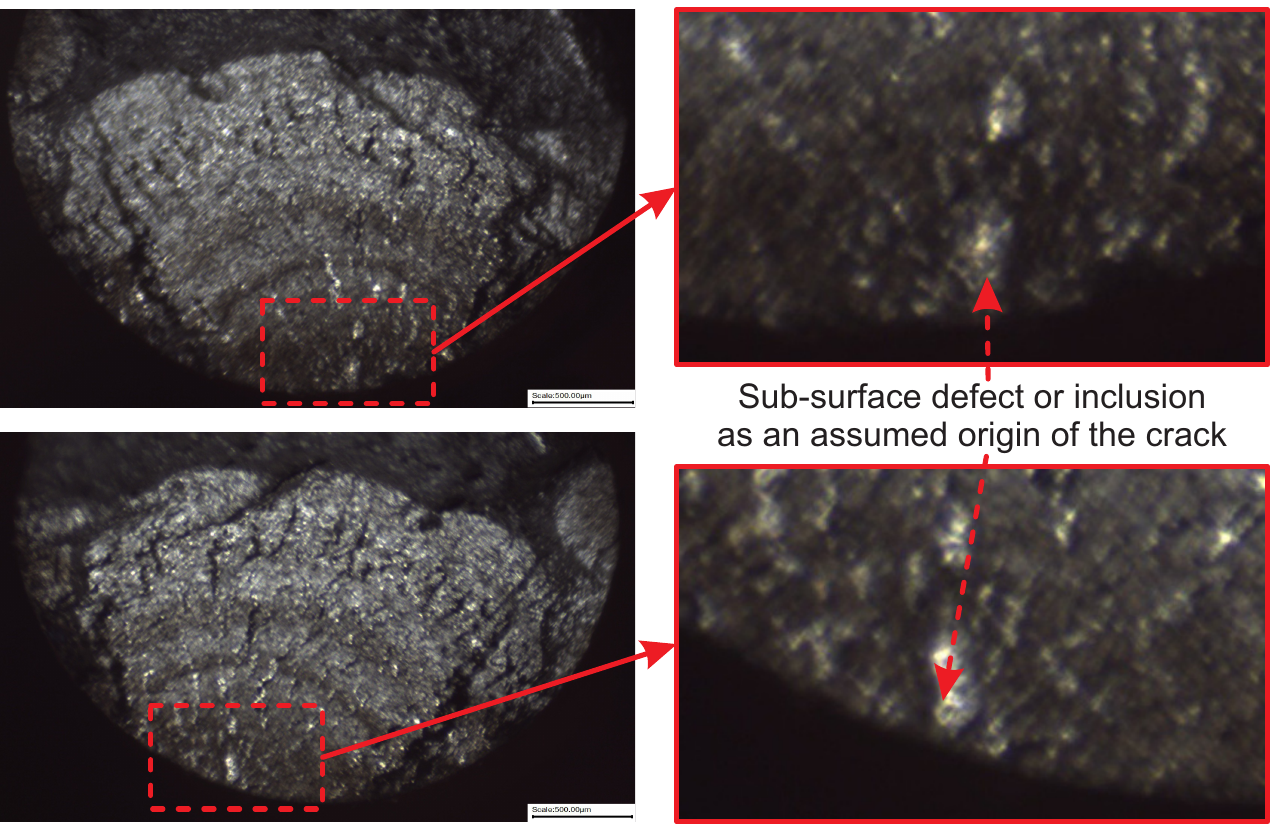
Figure 7. Search for the crack origin on the fracture surface of the sample run at 355 MPa stress amplitude for over 139 million cycles using Yenway optical stereo-microscope.